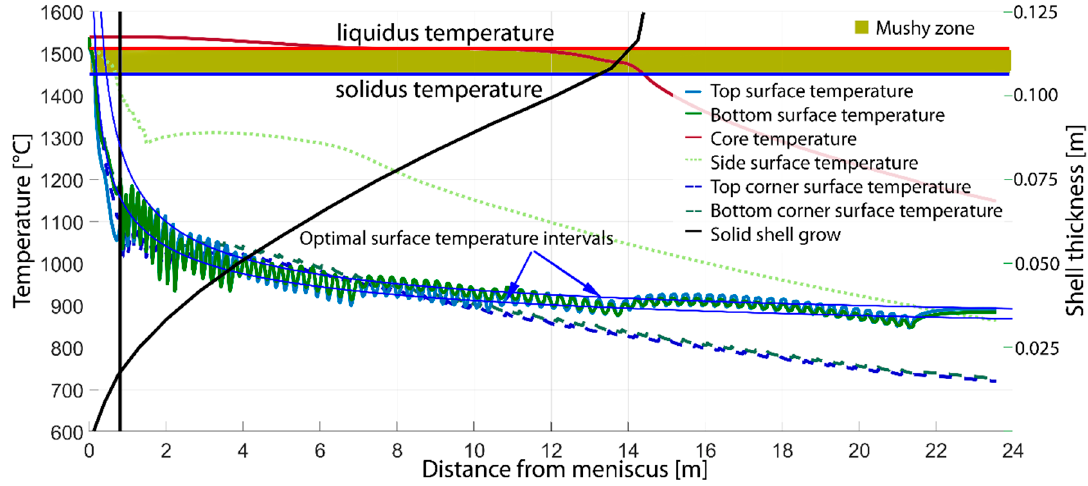
Figure 8. Optimal temperature field after fuzzy regulation. Table 3. Optimal cooling intensities for cooling loops and different casting